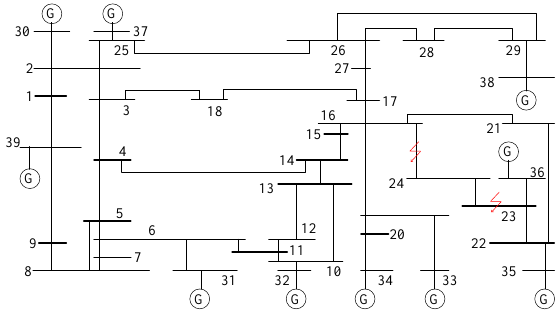
Figure 15. Double faults of the IEEE 39-bus system.